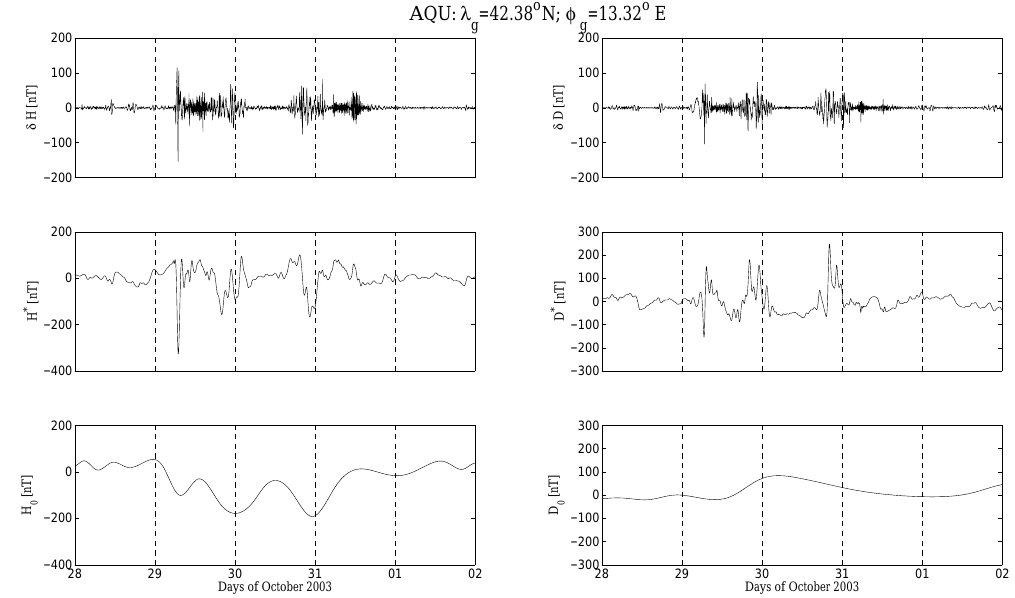
Figure 12. Halloween super storm, 28 October–1 November 2003: EMD reconstruction for the H (left panels) and D (right panels) compo- nents at midlatitude ground station (AQU: λ g = 42 . 38 ◦ N and φ g = 13 . 32 ◦ E). The time resolution is